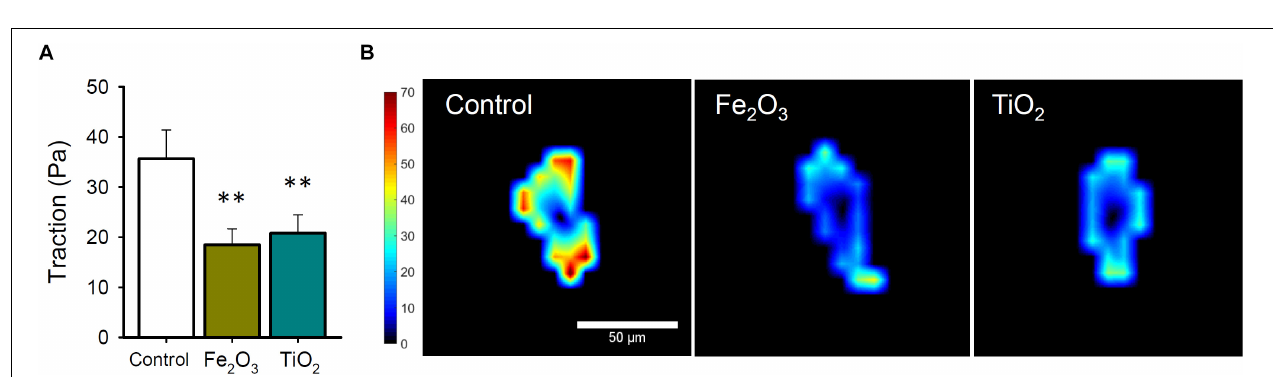
FIGURE 2 | (A) Cell stiffness after 24 h exposure to Fe 2 O 3 and TiO 2 (10 µ g/mL) NPs or culture medium (CTRL) ( n = 11). (B) Percentage of cells presenting actomyosin stress fibers after 24 h of exposure to Fe 2 O 3 and TiO 2 (10 µ g/mL) NPs or CTRL ( n = 6). (C) Examples of F-actin (red) and myosin light chain (green) stained cells. Data are presented as mean ± SE. ∗∗ P < 0.01.